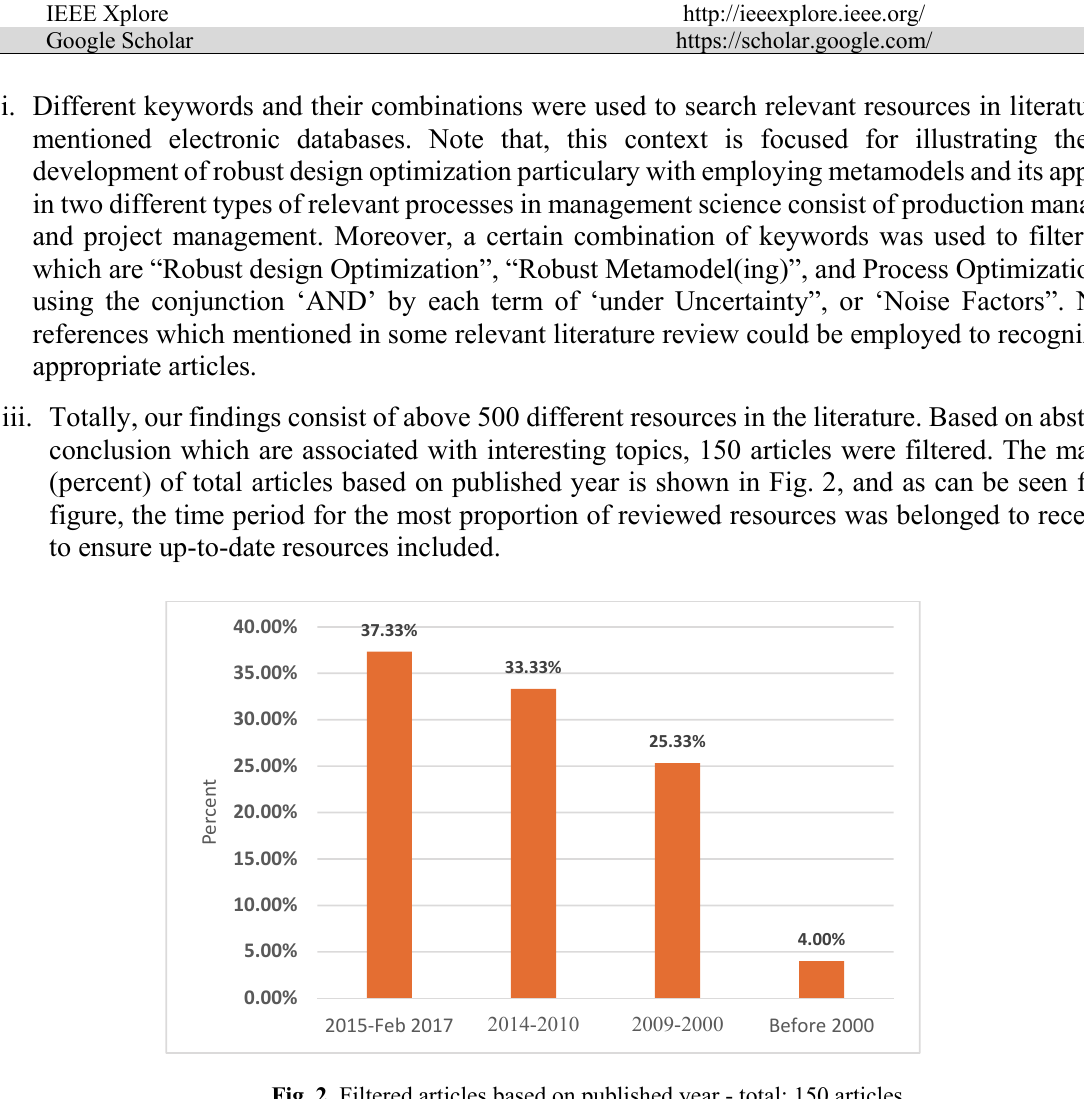
Fig. 2. Filtered articles based on published year - total: 150